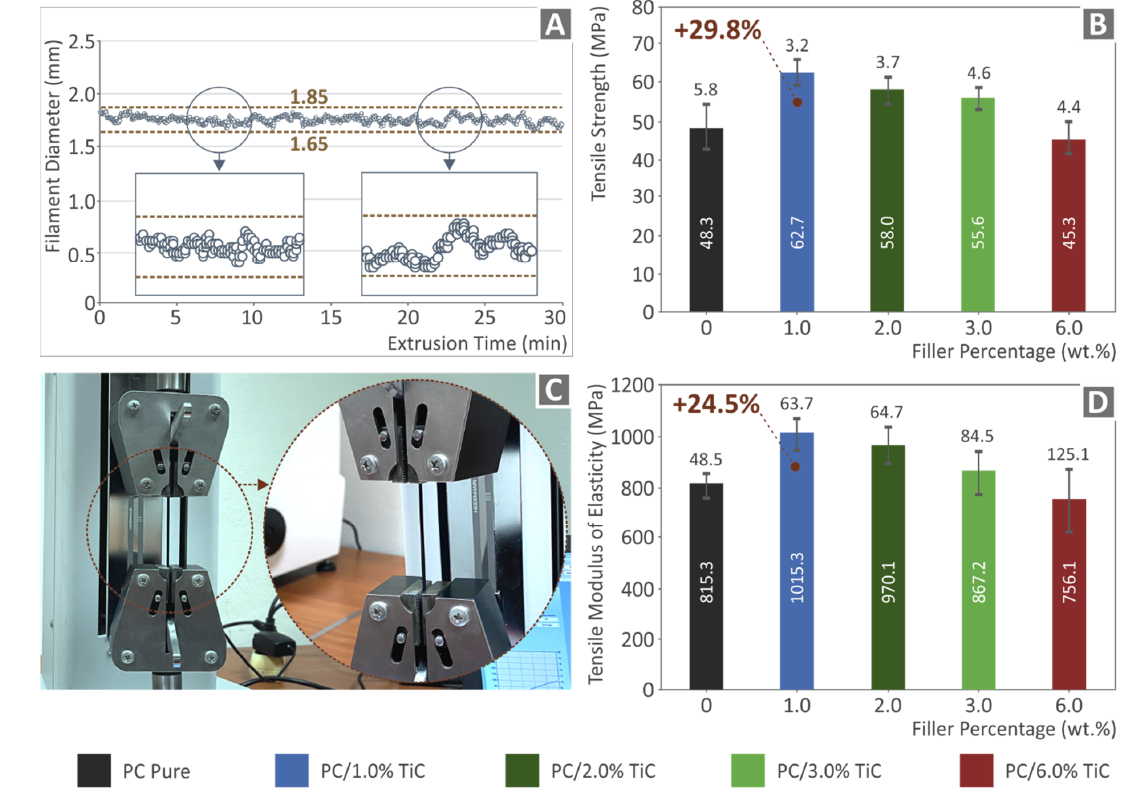
Figure 6. ( A ) Real-time diameter measurement of the produced filament during the filament extrusion process, ( B ) mean tensile strength values and deviation of the produced filament for all materials studied, ( C ) experimental setup for the produced filament tensile tests, and ( D ) mean tensile modulus of elasticity values and deviation of the produced filament for all materials studied.